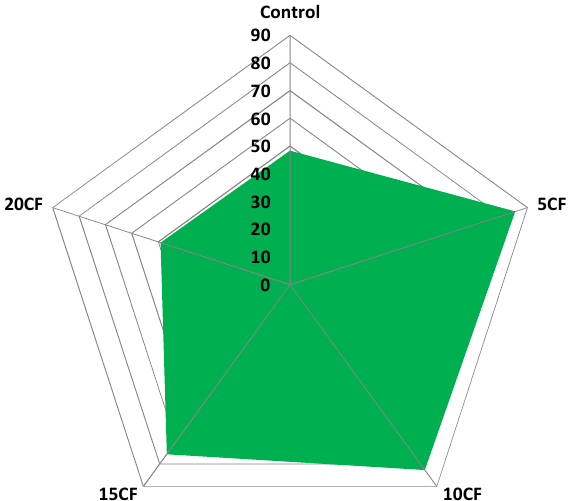
Figure 7. The structure and texture of the crumb of gluten-free breads with the addition of chestnut flour in the amount of 5% (5CF), 10% (10CF), 15% (15CF) and 20% (20CF). The last of the assessed characteristics of baked gluten-free bread was the assessment of consumer desirability, which is presented in Figure 8.